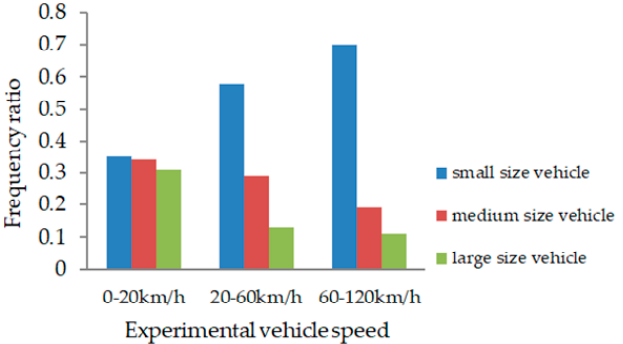
Figure 3. Occurrence frequency ratio of vehicles of different sizes at different experimental vehicle speeds. With increasing speed, the occurrence frequency ratio of small vehicles increases significantly, while that of other types, such as large vehicles, decreases continually.